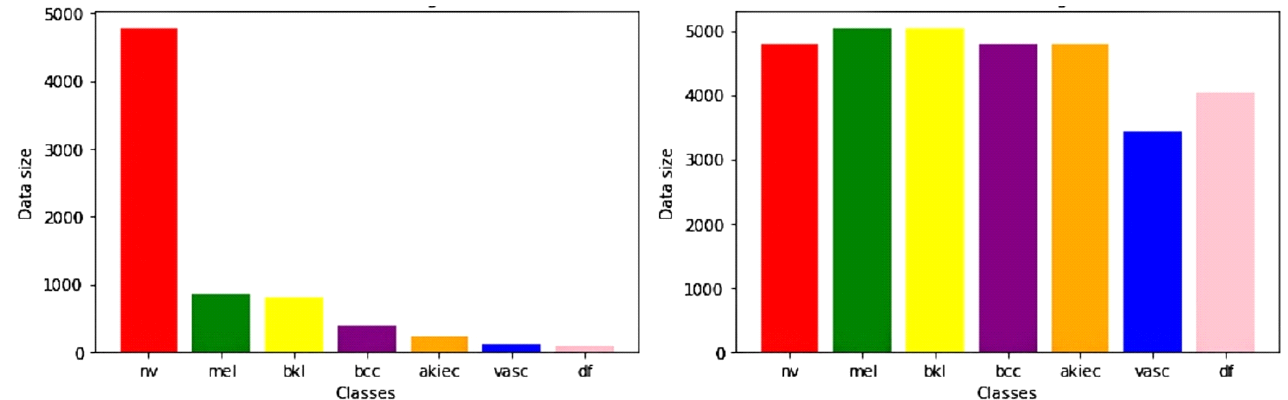
Figure 3. Class distribution before and after data